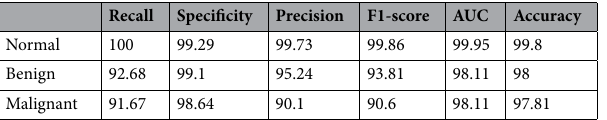
Table 6. Average individual performance of the proposed method for different classes.